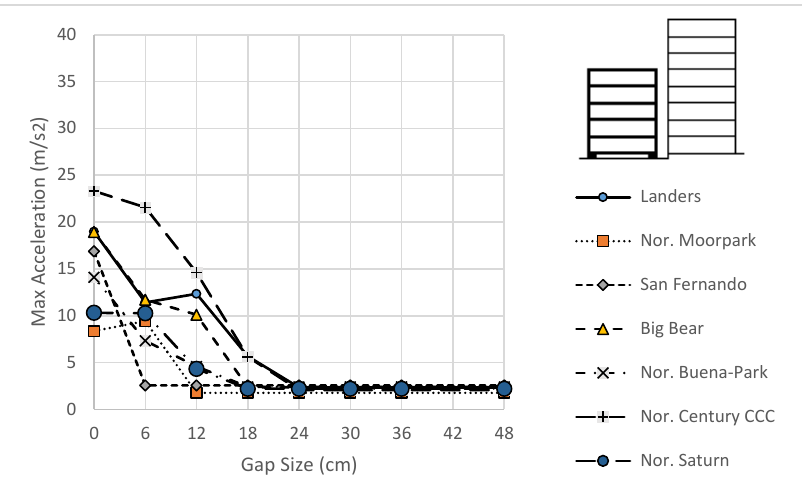
Figure 4. Peak accelerations of the 5th story of the base-isolated building with respect to different gap sizes for the second configuration under various earthquakes.